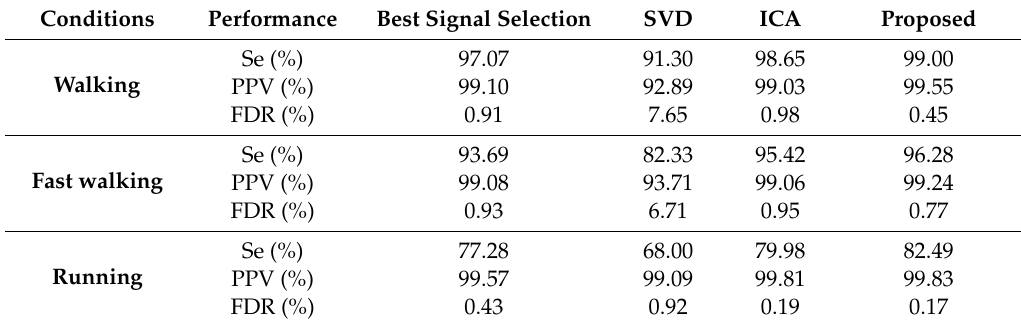
Table 2. Comparison of the results of Se, PPV, and FDR from algorithms based on the best signal selection method, SVD, ICA, or the proposed method for signals acquired under the walking, fast walking, and running